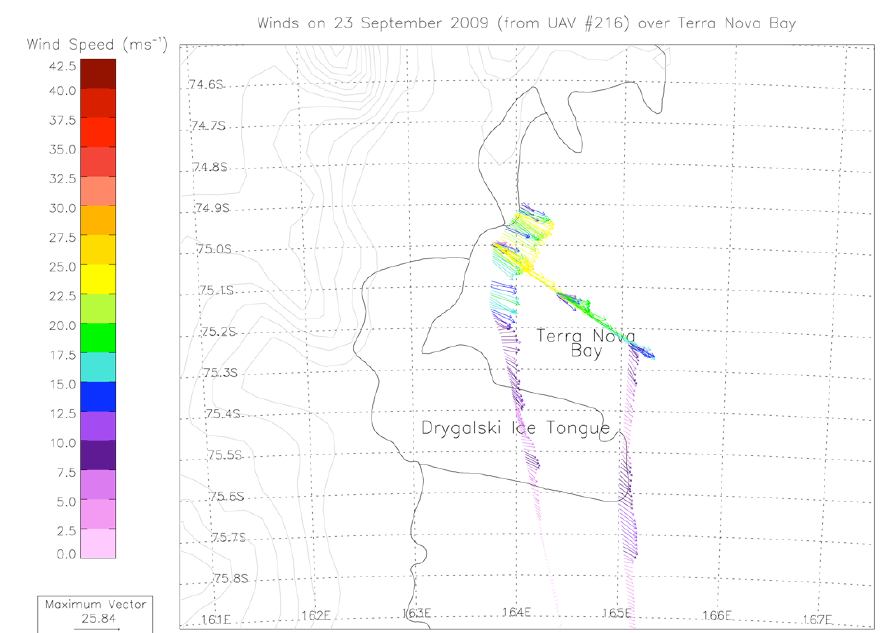
Figure 6. Winds observed during the 23 September 2009 UAS flight over Terra Nova